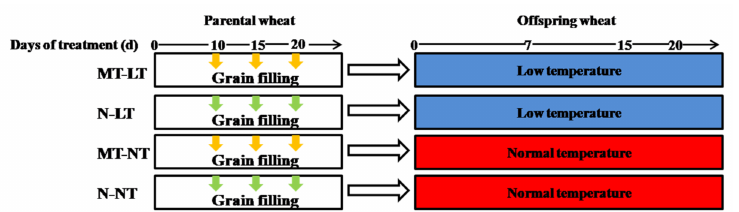
Figure 5. Schematic representation of